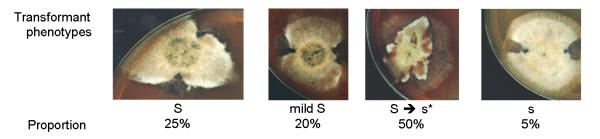
Types of transformants recovered in transformation experiments using s* mutants with XN31E6 and psecX5. As the respective proportion of each type of transformant was similar with both vectors, the proportion observed is the combined percentage computed with 60 tested transformants. S, transformants differentiating Secteurs as wild type; mild S, transformants differentiating a Secteur that propagates more slowly than wild type and that frequently reverts to a normal morphology. S → s*, transformants differentiating the Secteurs but showing an s* phenotype beyond the modified area; s, transformants unable to differentiate Secteurs.